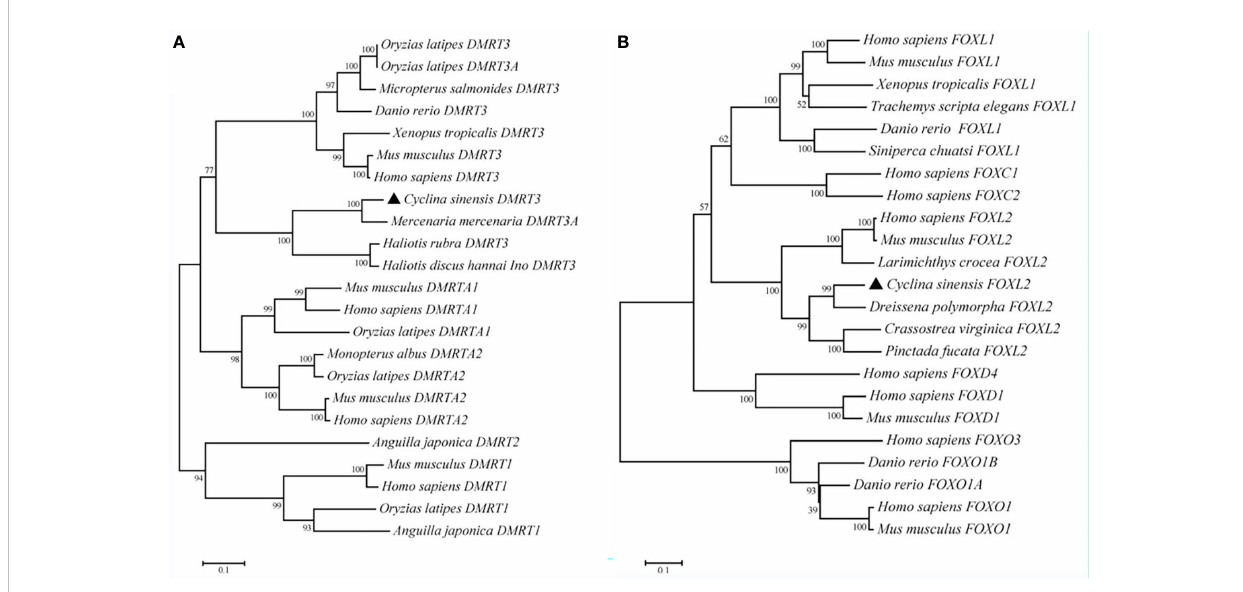
FIGURE 4 The phylogenetic tree of DMRT3 (A) and FOXL2 (B) from C. sinensis and other species. Note: C. sinensis were marked by a black triangle.